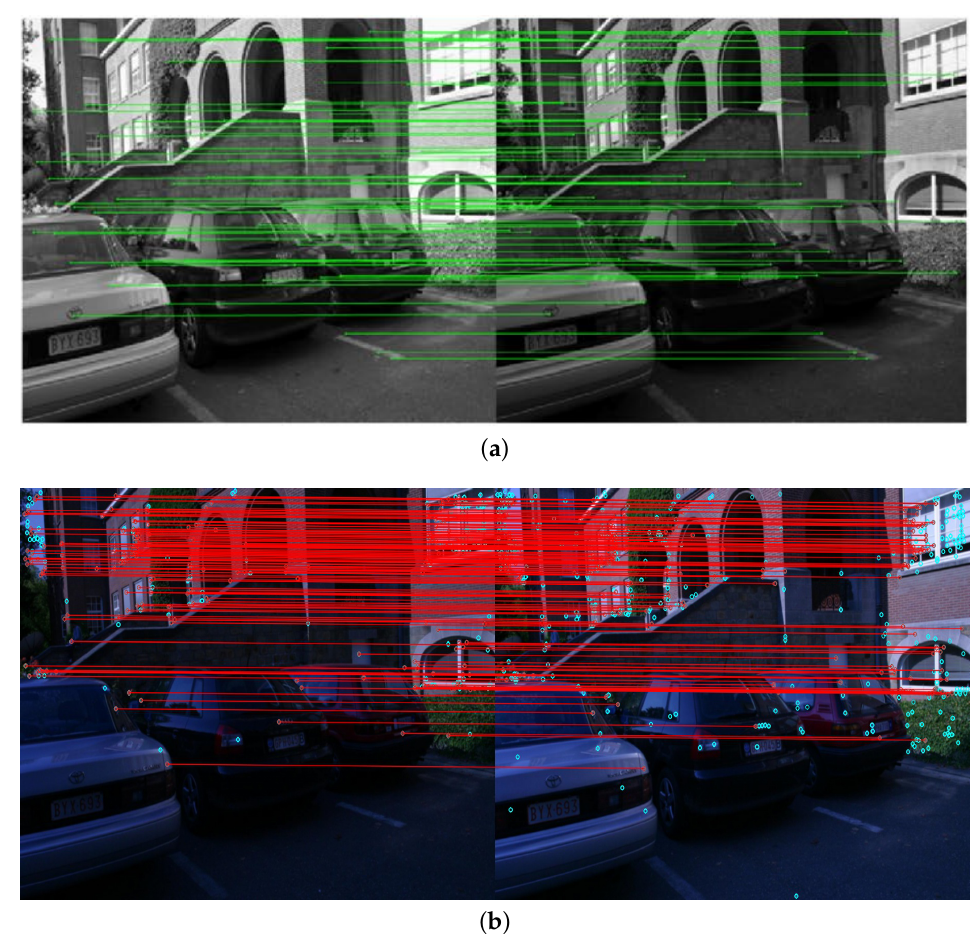
Figure 20. Matching results of images with different affine distortion. ( a ) The adaptive RKEM algorithm; ( b ) The algorithm in this paper.